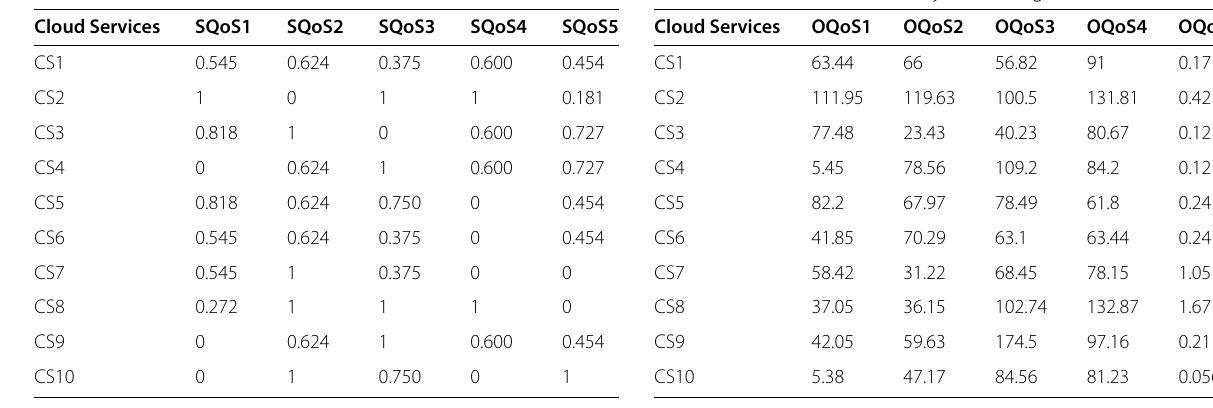
Table 8 Decision Matrix for Objective